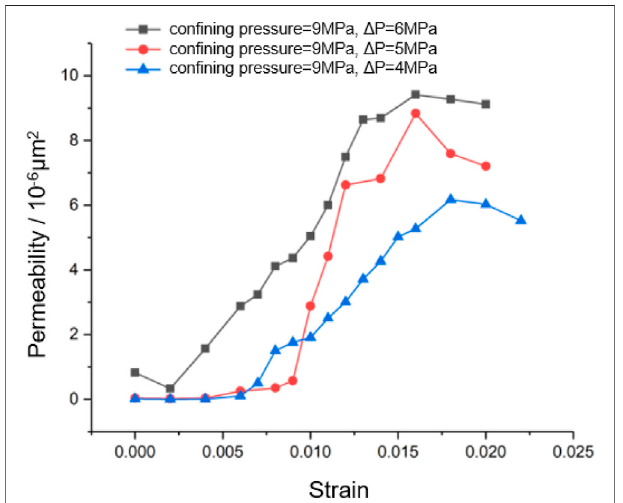
FIGURE 7 | The relationship curve between damage variables and equivalent plastic strain of specimens 1-5